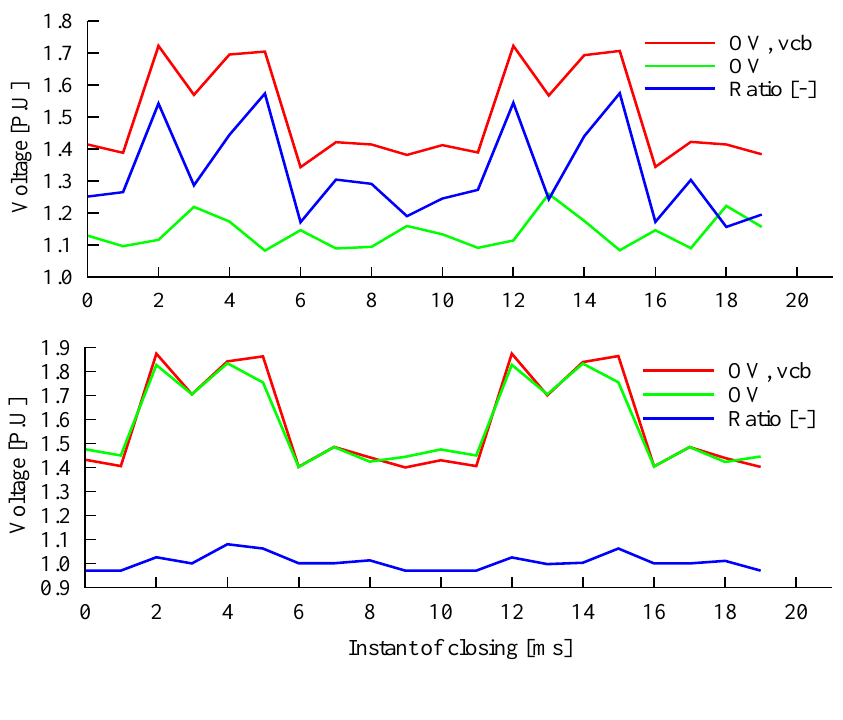
Figure 16. Simulated case SOV using the built-in switch and the detailed VCB description. Top plot at the platform and bottom plot at